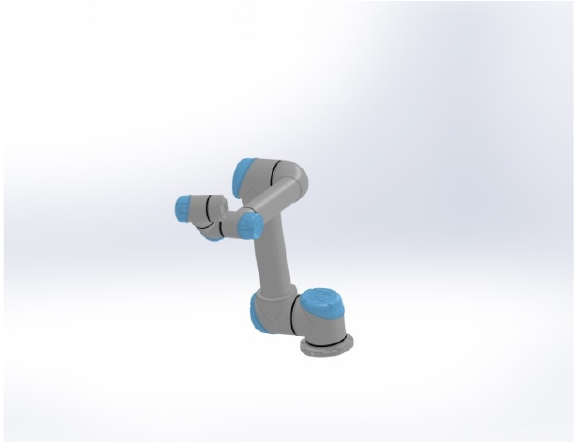
Figure 9. 3D drawings of the UR5 robot.